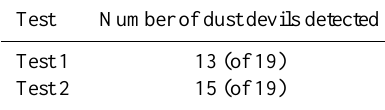
Table 5. Dust devils